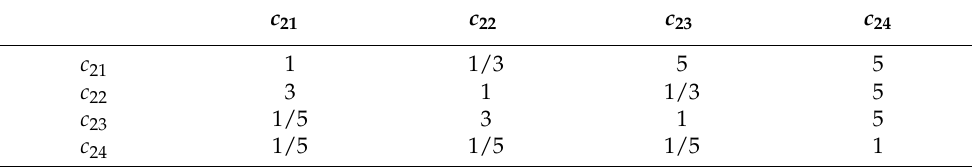
Table 6. Matrix for pairwise comparison of the sub-criteria of the physical condition.